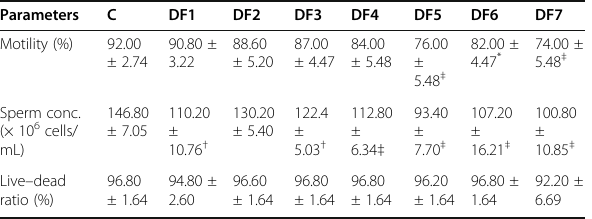
Table 5 Reproductive hormones of male Wistar rats after administration of hexane fraction of Waltheria indica Linn . root (Mean ± SD, n = 5 for each group) Parameters